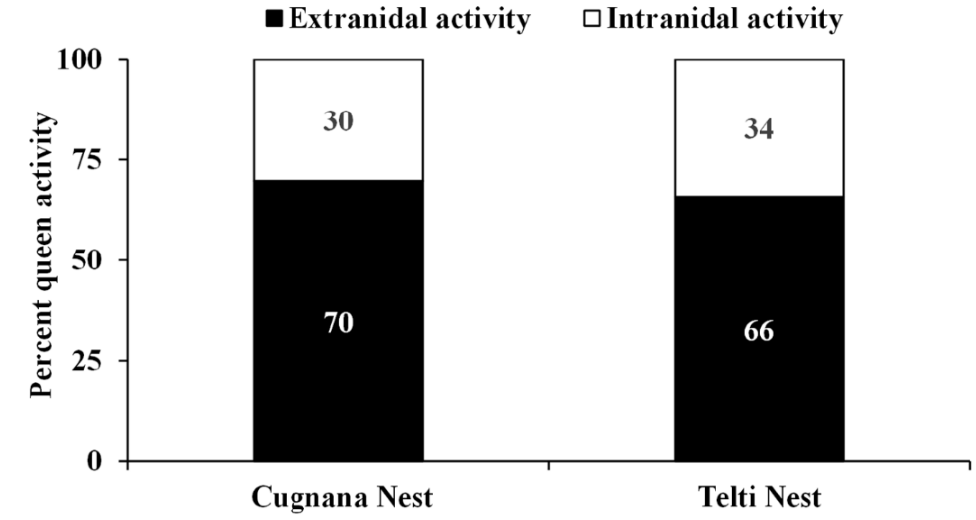
Figure 3. Relative frequency of extranidal and intranidal activity of European hornet queen on the total observation time (7 h) per nest (Cugnana and Telti nests, Sardinia, Italy). No significant differences were observed between the two nests (chi-squared = 0.47, df = 1, p = 0.49). In general, the daily activity of the queen began with the first flights at around 6:00 AM and lasted until 7:30/8:00 PM, when observations were stopped. Interestingly, the queen’s foraging activity was not interrupted by the